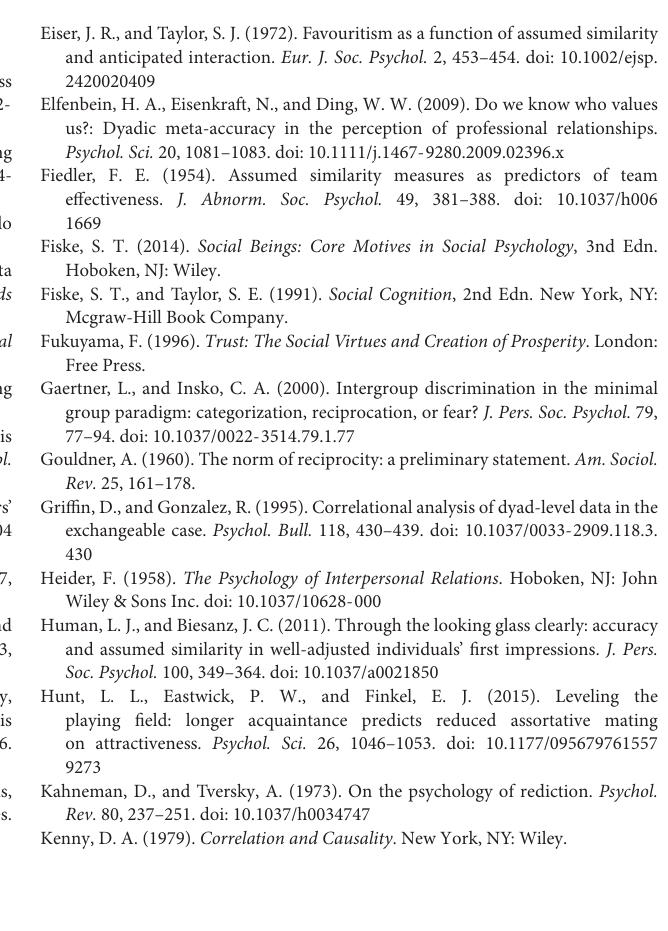
Supplementary Figure 1 | A latent variable model of ARRMA at the individual